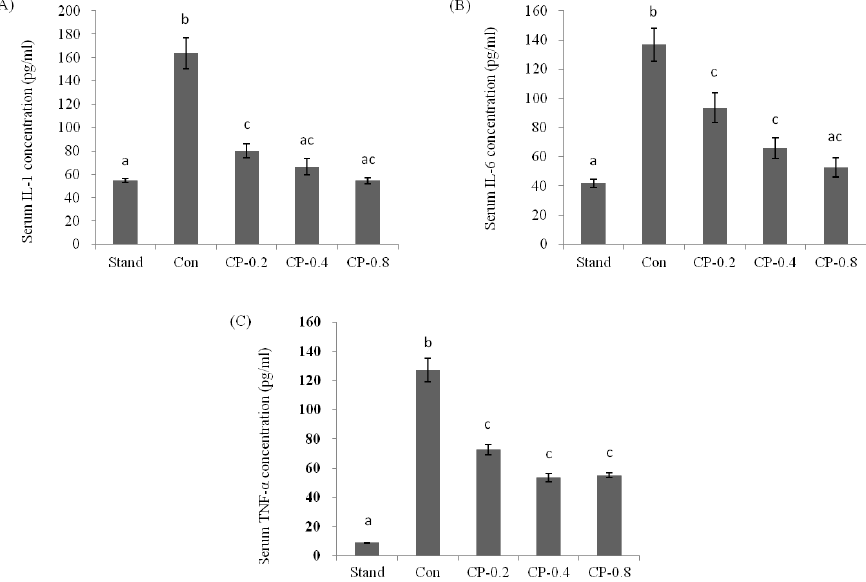
Figure 4. The effects of CPs on the levels of IL-1 ( A ), IL-6 ( B ), and TNF- α ( C ) in mice serum at 12 h after ethanol treatment. Values are expressed as mean ± SEM ( n = 5–10). Values with different letters are significantly different at p < 0.05.